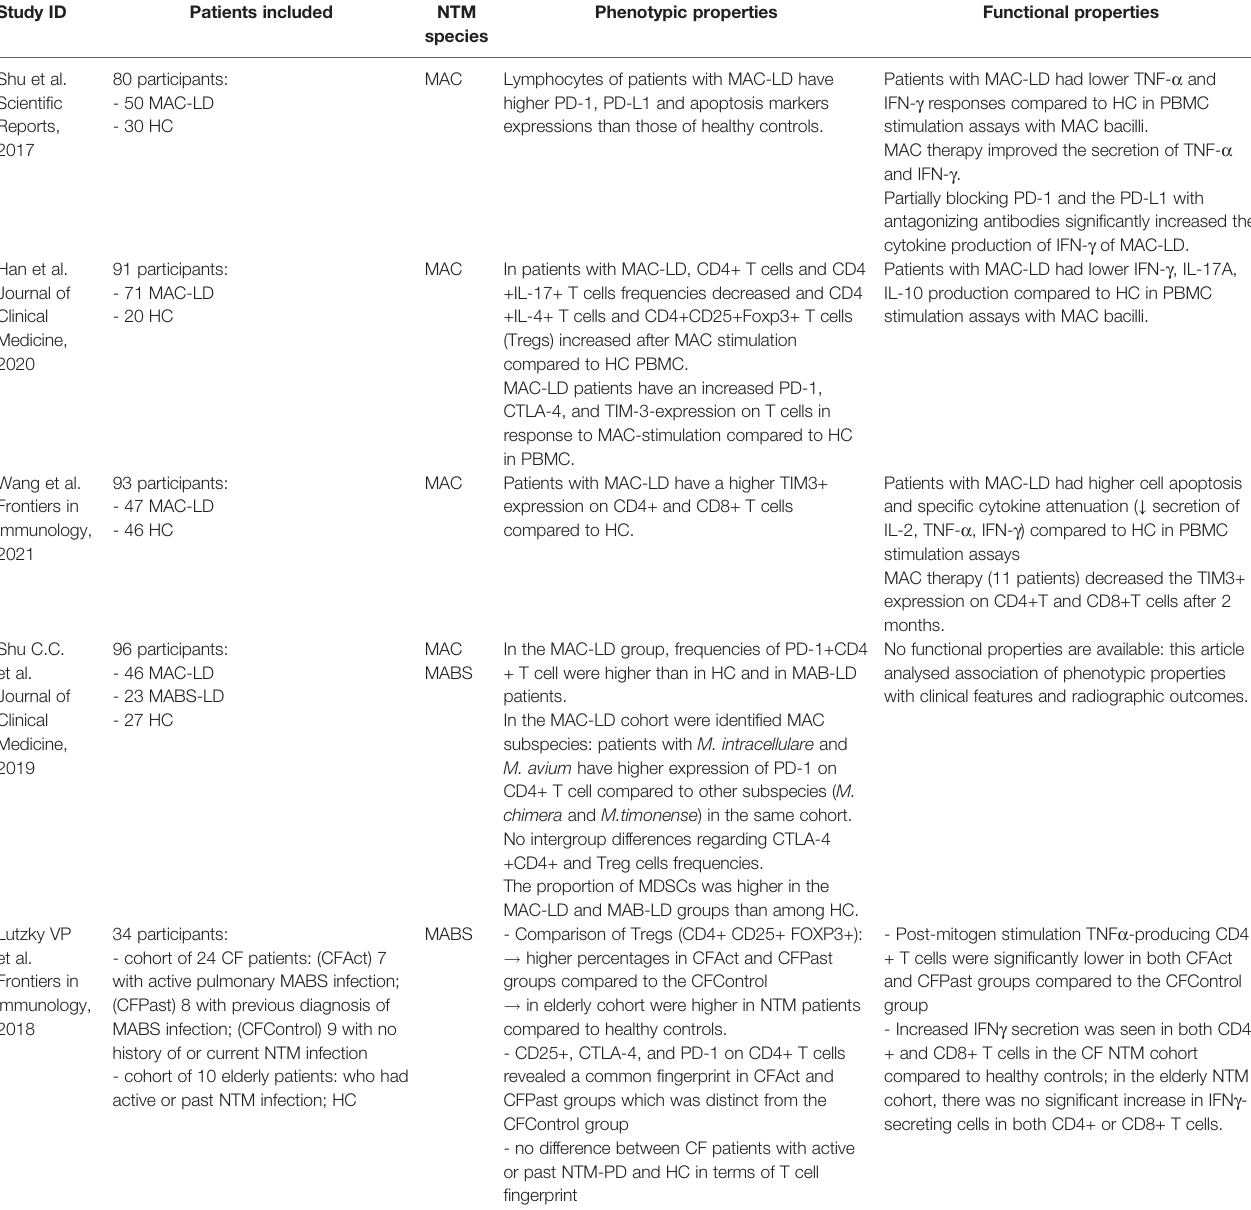
TABLE 1 | Summary of studies investigating conventional T cell immune exhaustion in